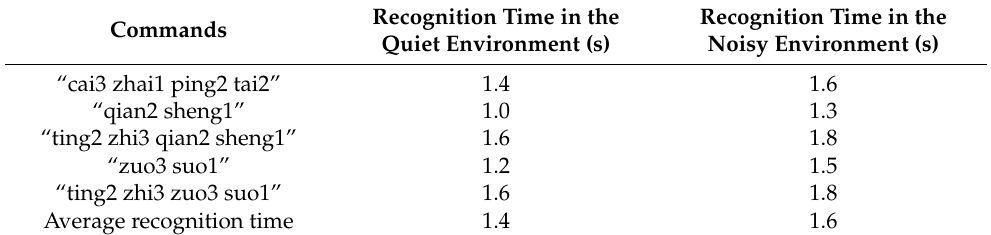
Table 6. Recognition time of the operation voice system in the two environments.